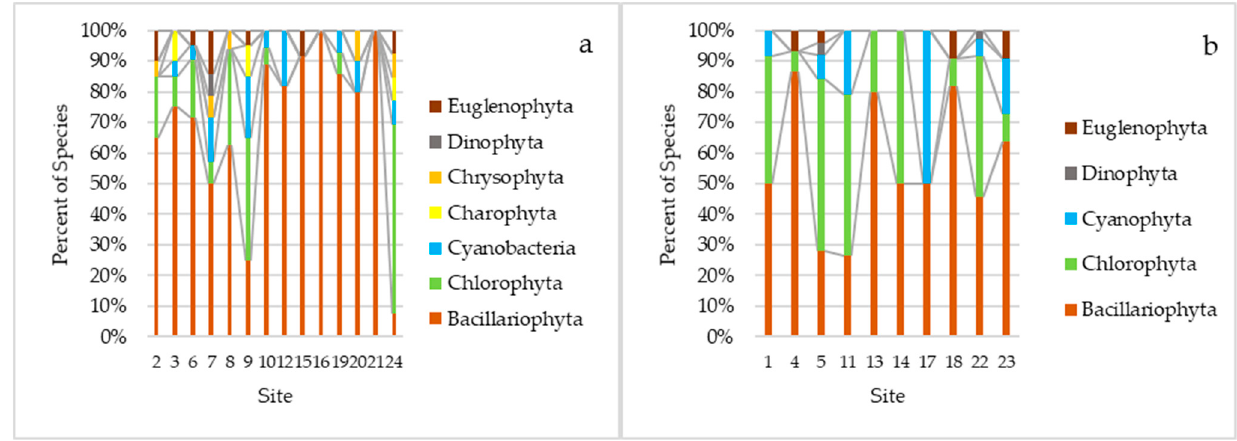
Figure 3. Divisions of phytoplankton grouped according to size of rivers: S and M ( a ); L and XL ( b ) in the Siversky Donets river basin (Ukrainian part).